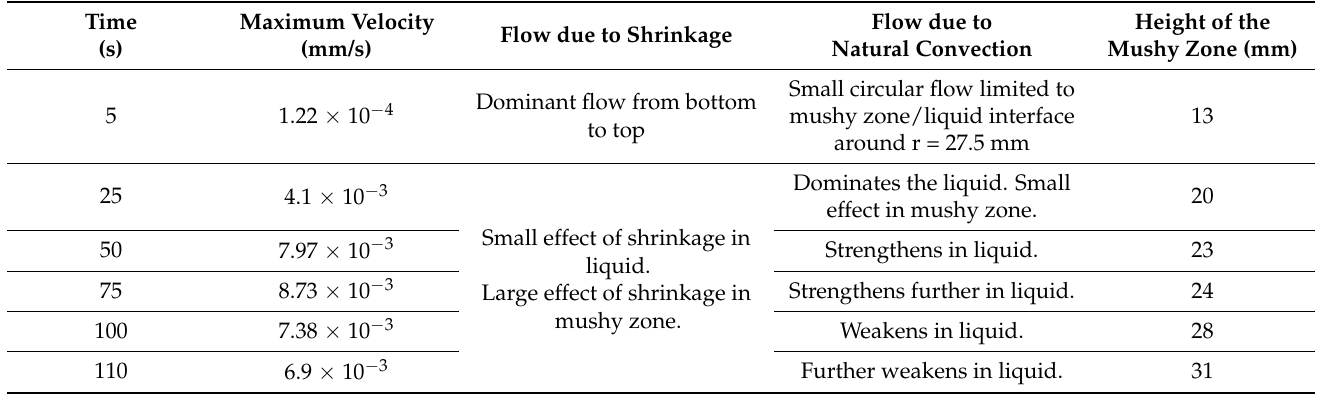
Table 4. Development of fluid flow for simulation